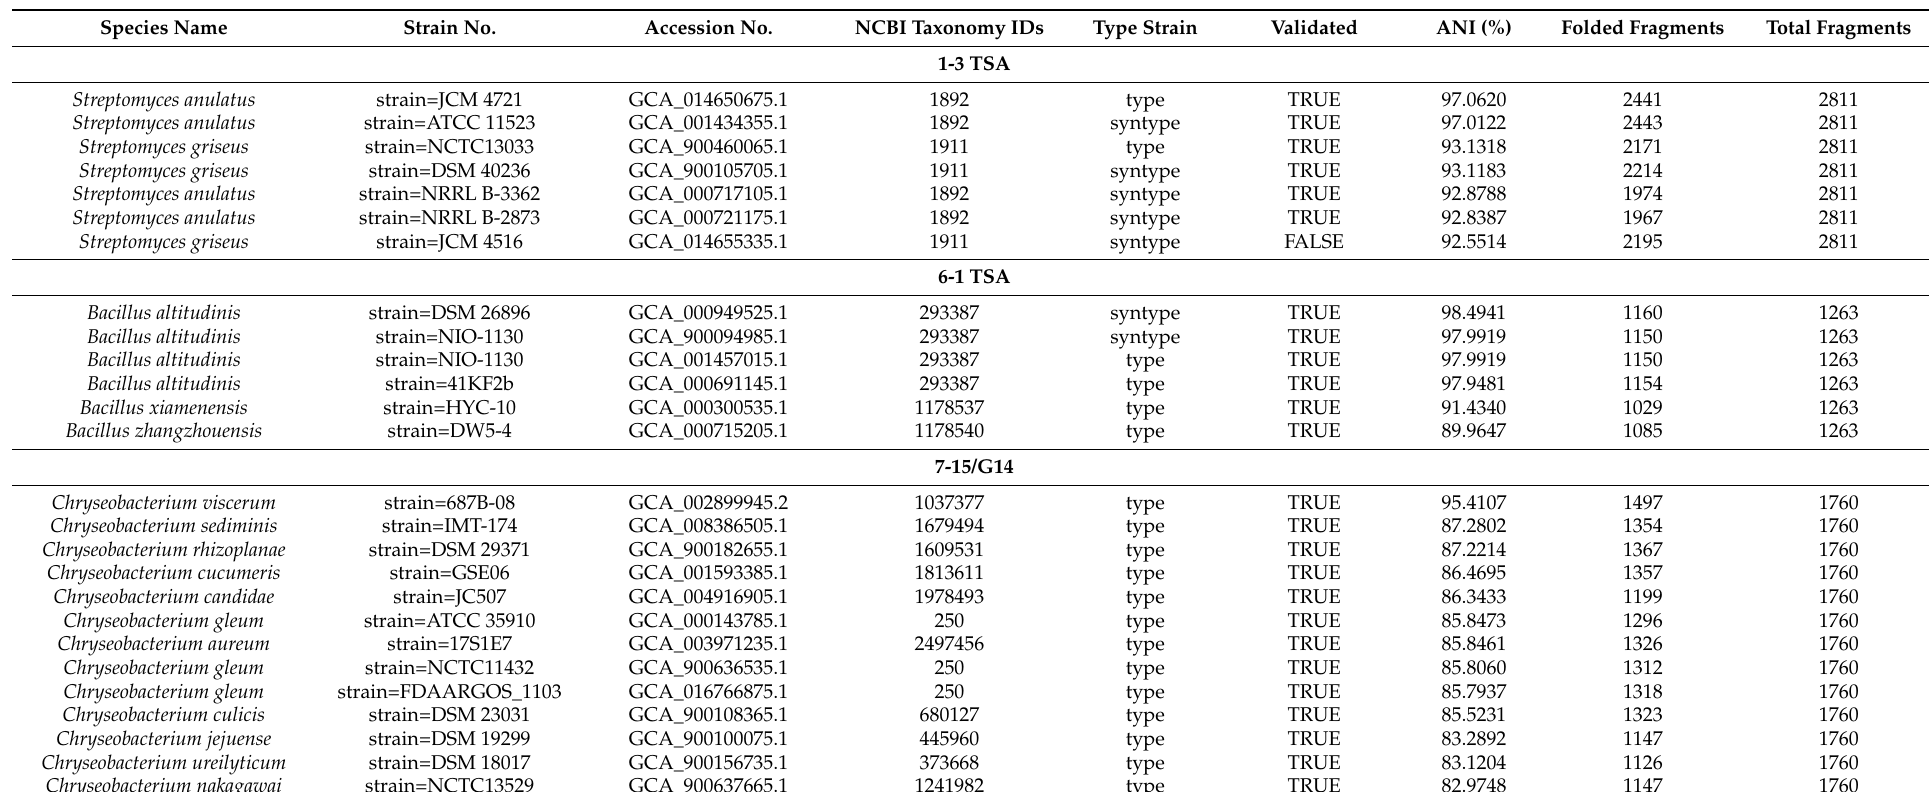
Table 5. Taxonomic annotation and phylogenetic analysis of selected